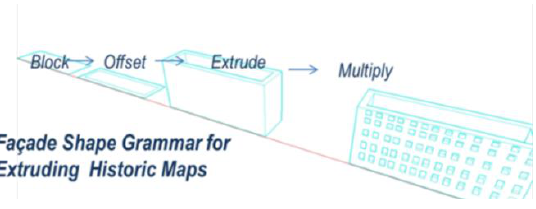
Figure 3 . Applied Shape Grammars to facades and street Classical Architecture Dublin.